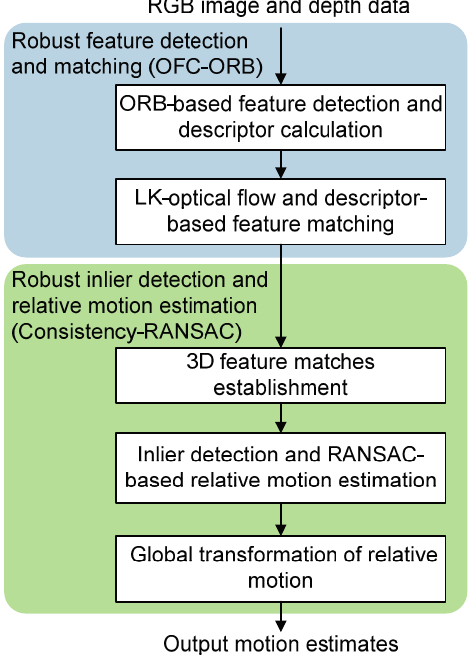
Figure 2. Process flow of the robust RGB-D visual odometry. ORB, oriented FAST and rotated BRIEF algorithm; OFC-ORB, optical flow-constrained ORB; RANSAC, random sample consensus